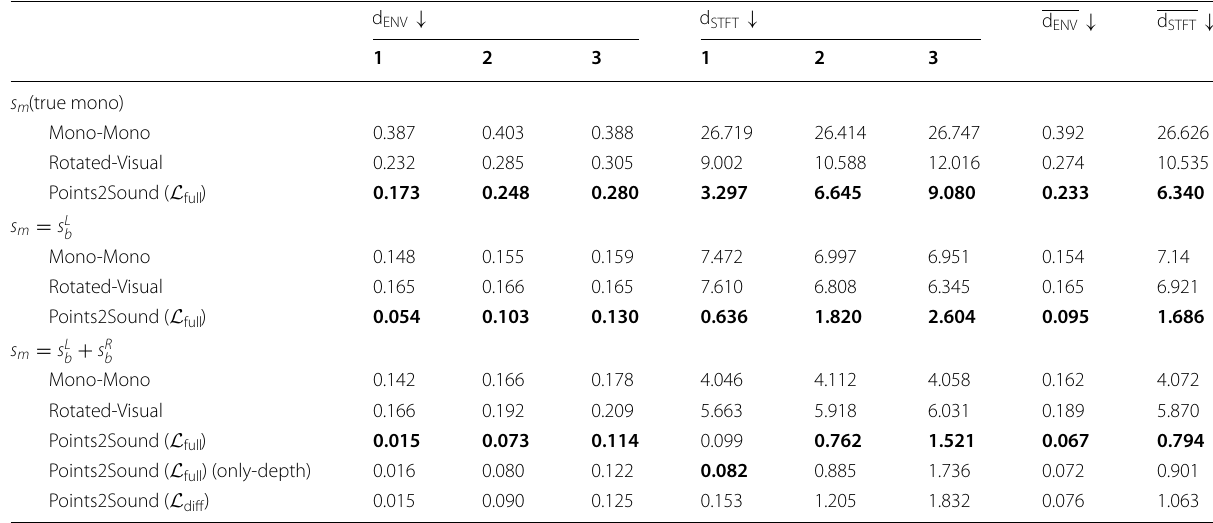
The lowest errors are highlighted using bold font